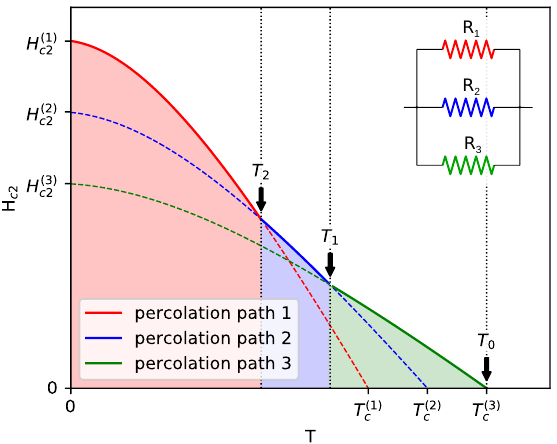
Figure 8. Illustration of percolation path formation when temperature T is decreasing, T > T ( 2 ) ( 1 ) < T < T ( 3 ) < T < T ( 2 ) ( a ), T c c c ( b ), T c ( c ), and T represent connected superconducting regions characterized by parameters ( T ( 1 ) ( 1 ) ) , respectively. and ( T c , H c 2